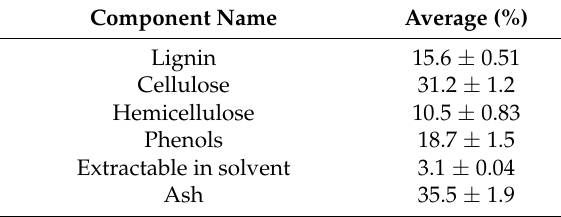
Table 1. Main characteristics of macroalgae